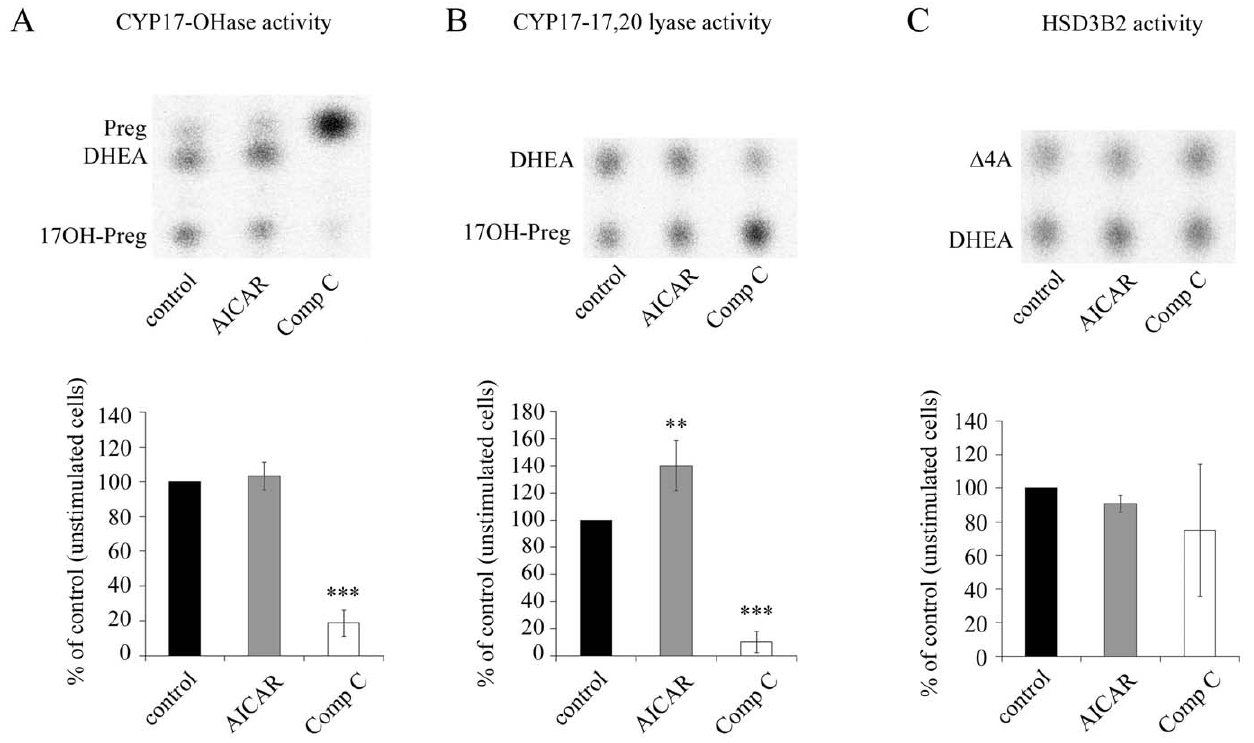
Figure 4. Effect of AMPK activator AICAR and inhibitor compound C on steroidogenesis in NCI-H295R cells. NCI-H295R cells were either stimulated with 1 mM AICAR or inhibited with 20 m M compound C (Comp C) for 48 h. HSD3B2 activity was blocked by 1 m M trilostane to specifically study the CYP17-OHase and CYP17-17,20 lyase activities. HSD3B2 activity was studied as a conversion of DHEA into androstenedione. Steroidogenesis was either labeled using 100,000 cpm/35-mm well of ( 3 H) pregnenolone (Preg), ( 3 H) 17OH pregnenolone (17OH-Preg) or ( 3 H) dehydroepiandrosterone (DHEA) as substrates for 90 min. Steroids were extracted from medium and resolved on TLC plates. A–C, representative TLCs (upper panel) and quantifications (lower panel) of CYP17-OHase (A), CYP17-17,20 lyase (B) and HSD3B2 (C) activities. Quantification was performed on four independent experiments. Results are expressed as a percentage of control, error bars are 6 S.D. D 4A, androstenedione. **, P , 0.01; ***, P ,